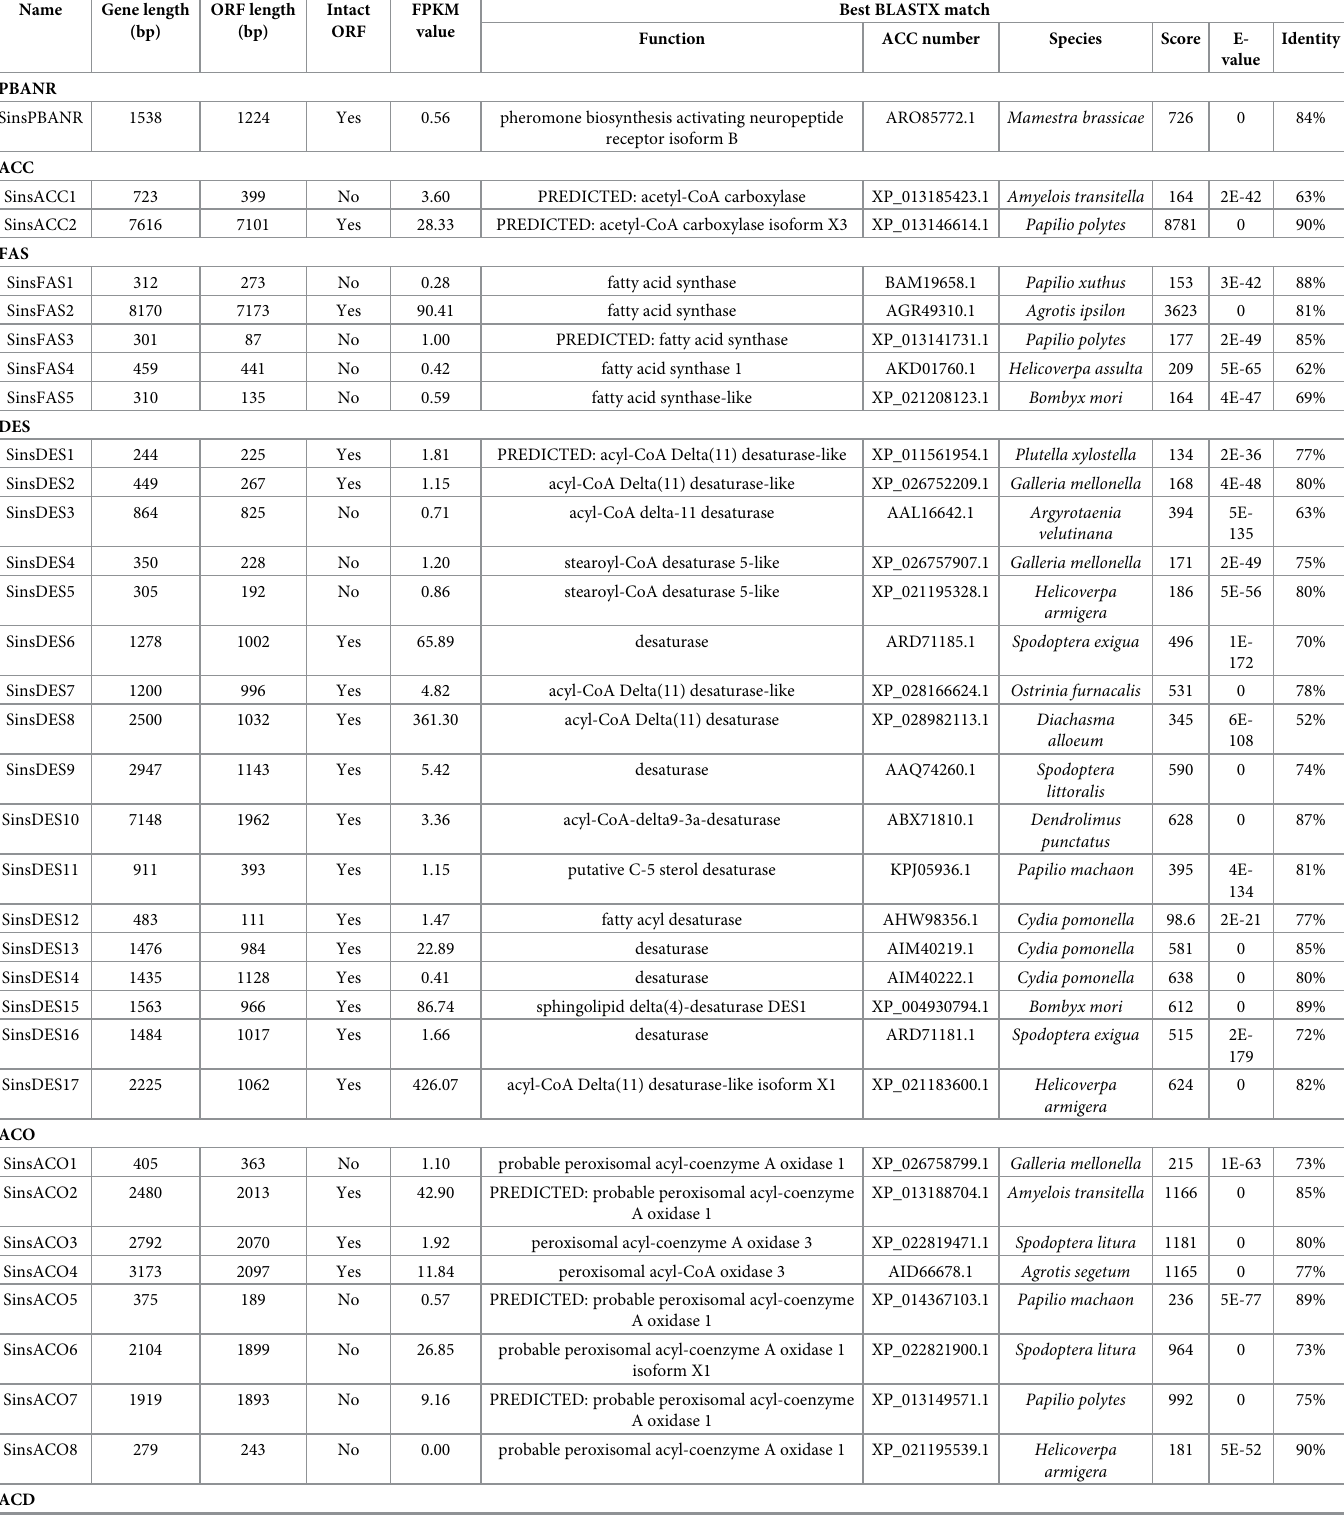
Table 2. Putative sex pheromone biosynthesis-related genes identified in the S . insularis pheromone gland transcriptome.